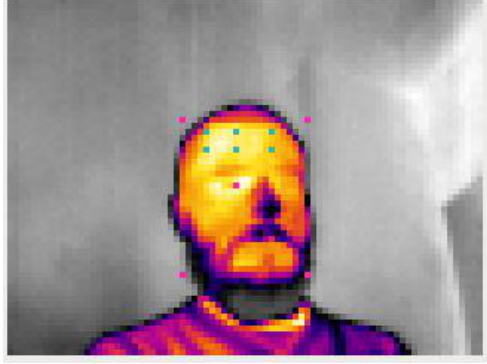
Figure 2. A screenshot of the image acquired with the Lepton IR camera.